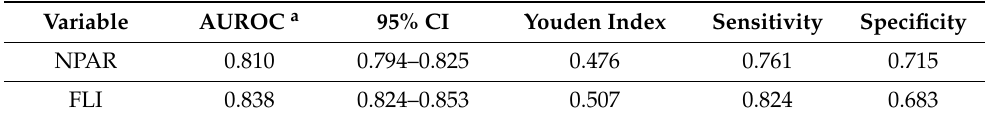
Table 4. ROC analysis of the diagnostic performances of NPAR for NAFLD and FLI in individuals without DM.